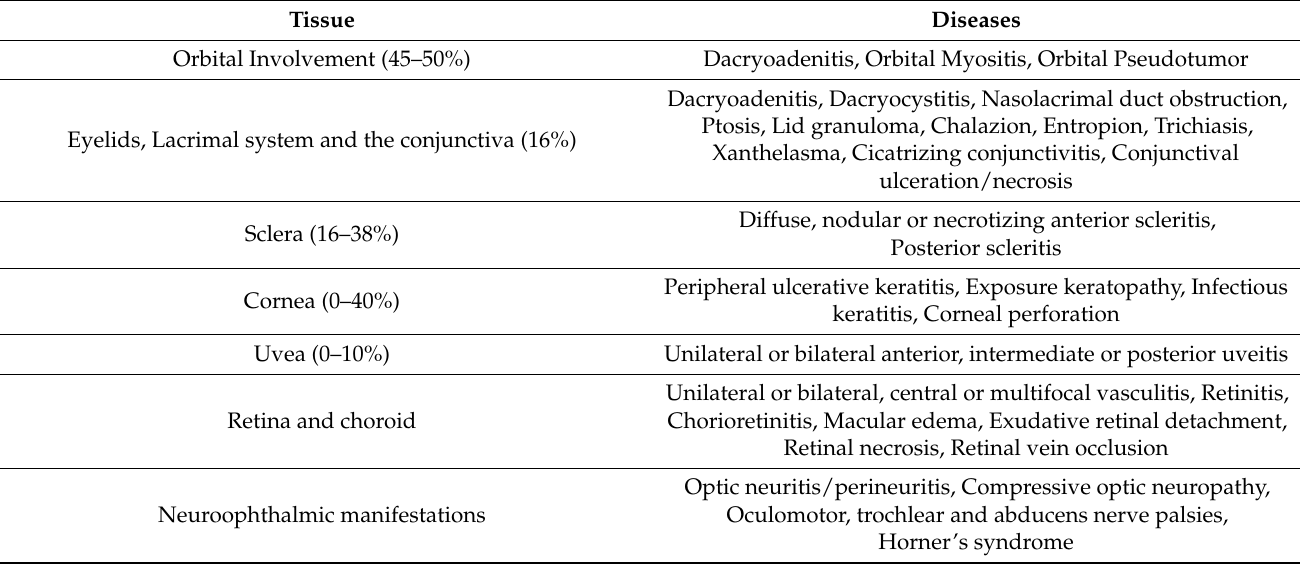
Table 1. Ocular manifestations of Wegener